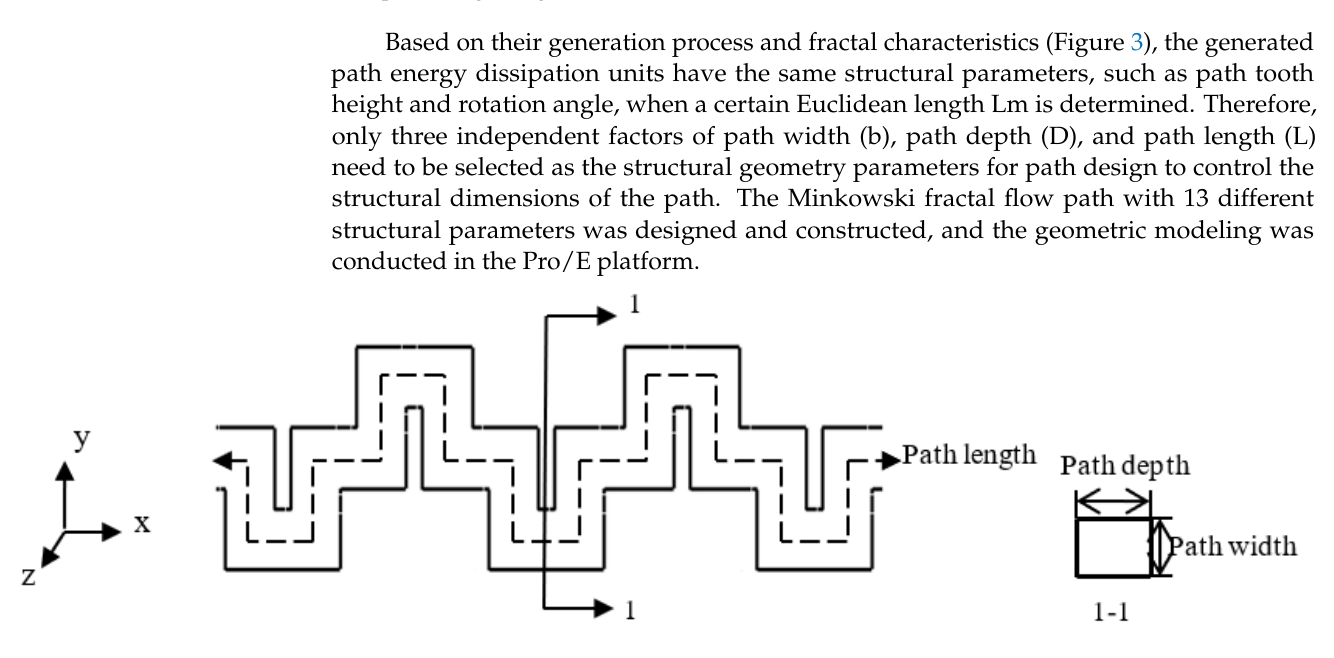
( b ) Figure 4. Particle distribution images of flow path cells at adjacent moments. ( a ) time T1; ( b ) time T1 + 0.01 s. 2.1.4. Numerical Design of Experiments According to the characteristics of the fractal flow path, it is known that the width, depth, and length of the flow path are the key parameters. Therefore, three basic parame- ters were selected for the study in the following ranges: path width within [0.9 mm, 1.3 mm], path depth within [0.9 mm, 1.3 mm], and path length within [128 mm, 256 mm].